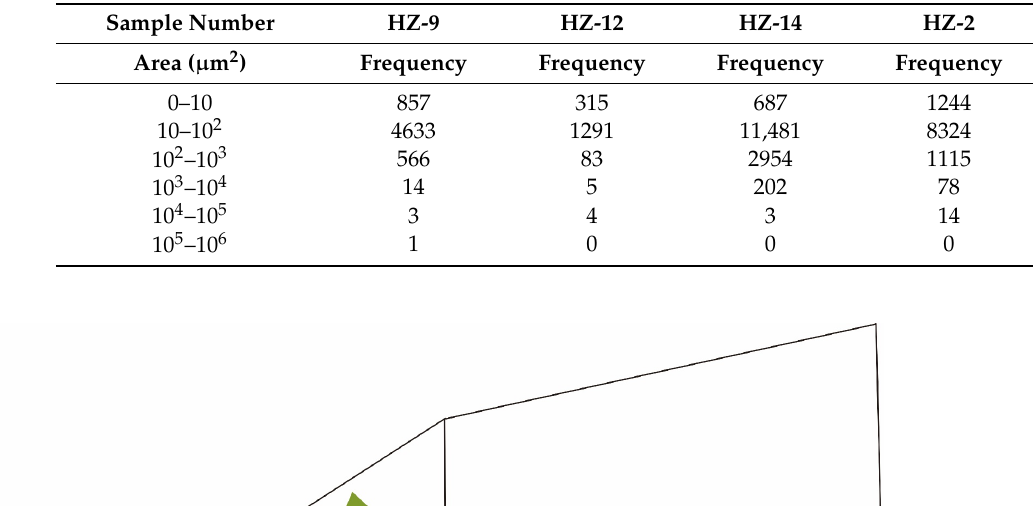
Table 5. Test results of the pore surface area of the carbonate rock samples in the Huize lead–zinc deposit.